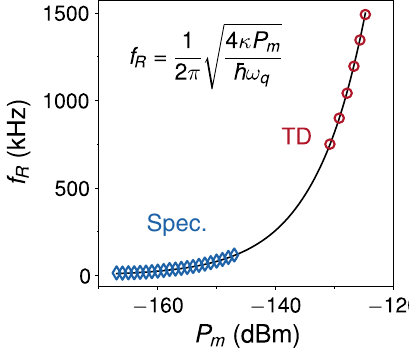
Ω = ð 2 π Þ from spectroscopy and FIG. 8. Rabi frequency f R ¼ R time-domain measurements. The blue markers (labeled spec.) indicate the Rabi frequency extracted from fits to the frequency dependence of the reflection coefficient according to Eq. (C8), similar to Fig. 2, while the red markers indicate the values extracted from the time-domain (TD) measurements shown in Fig. 4(a). Both spectroscopy and time-domain datasets were taken in the same cooldown (run no. 7). The black solid line represents the expected Rabi frequency for an ideal qubit according to 2 ℏ ω α P Eq. (C7), and using P m ¼ q j in ¼ in j